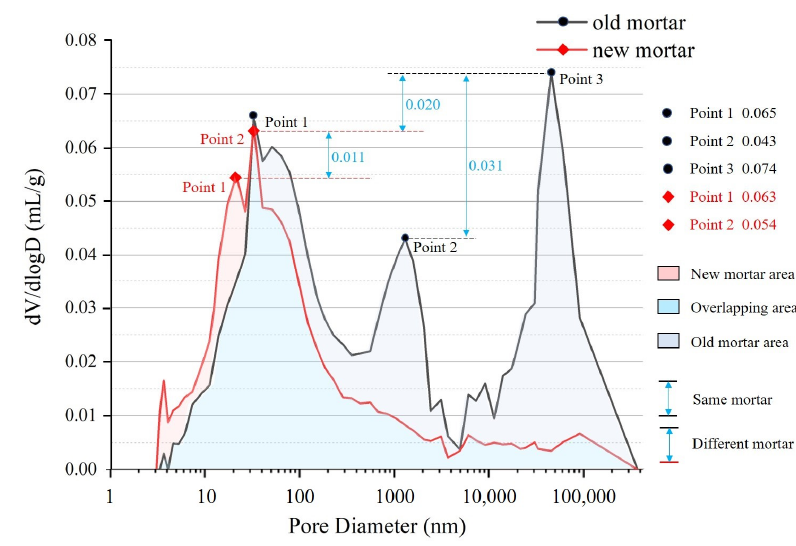
Figure 2. Trends of dV / dlogD pore volume and pore size for OM and NM. With the increase in initial pressure, the increment of invasion of OM is more obvious than that of NM, which means that not only the maximum diameter but also the connectivity of OM pores also greatly exceeds that of NM. As shown in Figure 3a, the early intrusion increment limit point 1 of the OM takes a value of 11.41%, which is about 232% of the NM result (4.91%); at subsequent pressure increments, the cumulative porosity varies in the range of 0.22% to 1.85%. However, at the end of the mercury compression process, the intrusion increment of the OM is significantly lower compared to the NM, which also indicates that the connectivity of the OM in the micropores is much lower than that of the NM. The intrusion increment limit point 3 of the OM takes a value of 4.10%, which is about 55.7% of the peak intrusion increment limit point 4 of the NM (7.18%), as shown in Figure 3b.